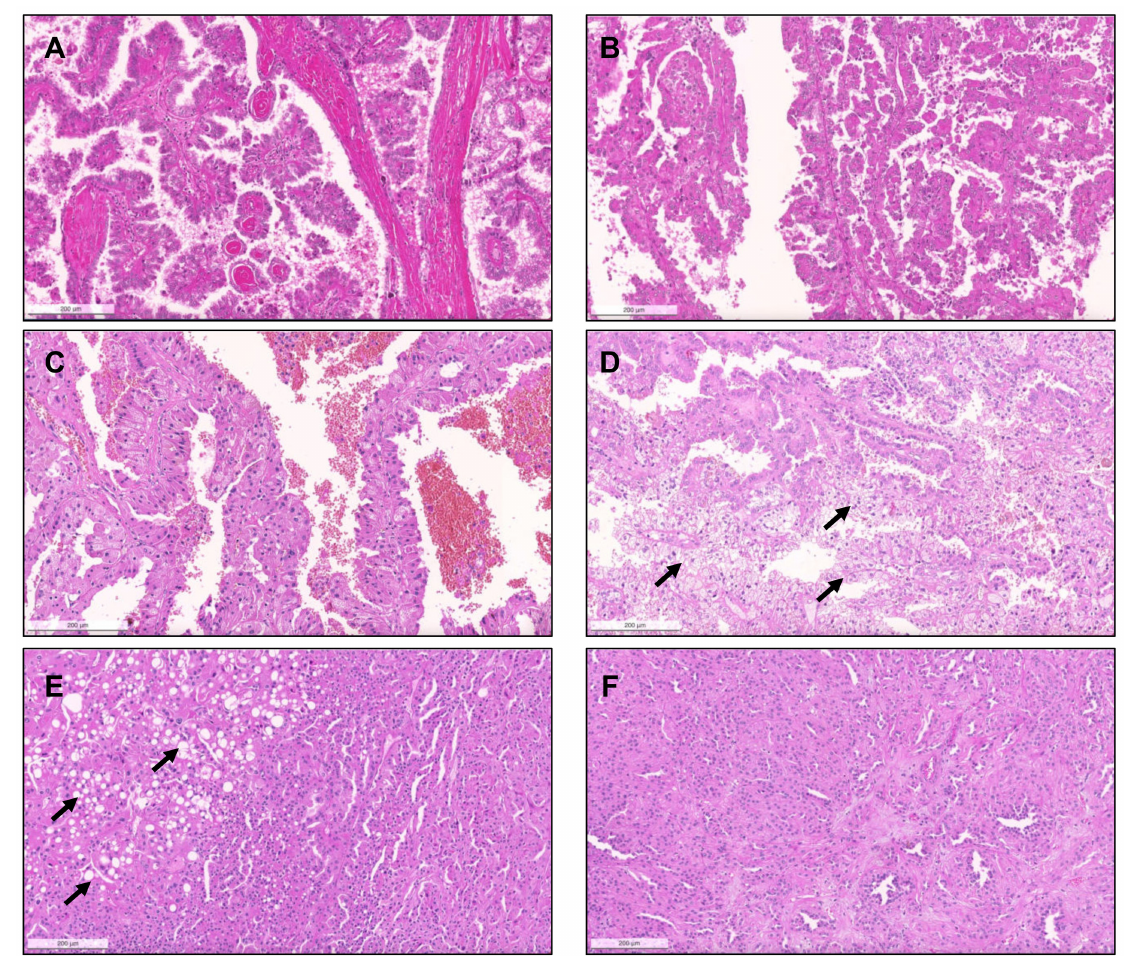
Figure 3. The spectrum of type 2 pRCC. Traditionally, these tumors are characterized by more complex papillae, covered by larger cells, with eosinophilic cytoplasm, usually of higher nuclear grade and with nuclear pseudostratification ( A – C ). Clear cells can be present (( D ), arrows), as well as areas of vacuolation (( E ), arrows). As for type 1 pRCC, a solid pattern can also occur, with packed papillae/tubules which are only discernible at high power magnification ( F